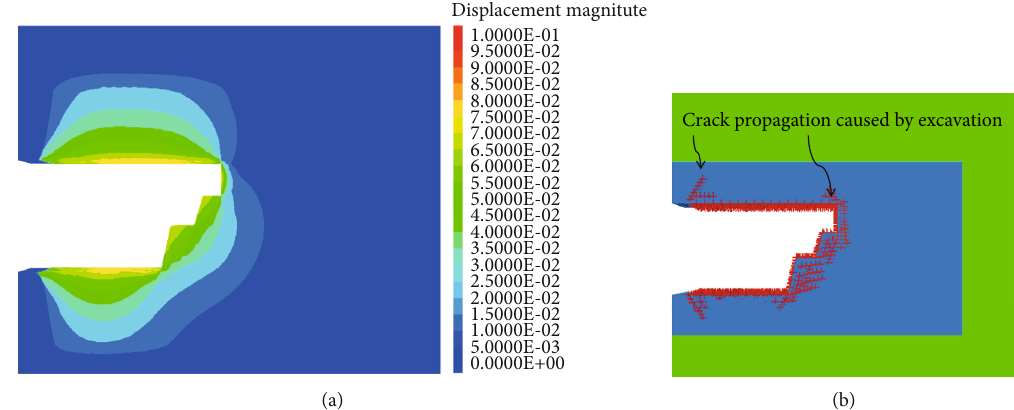
Figure 7: Tunnel displacement and crack propagation when safety thickness is 7m. (a) Displacement nephogram. (b) Fracture fi eld